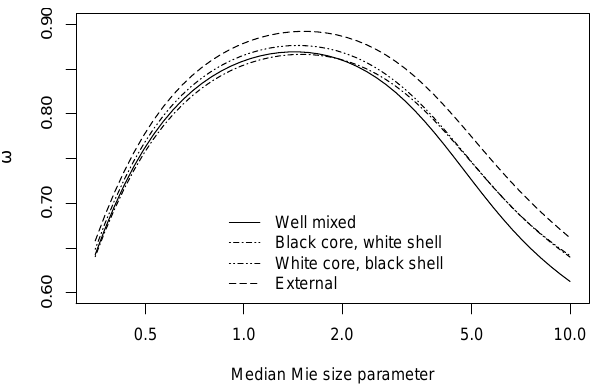
Figure 4. Relative difference of the absorption efficiency for well-mixed and core-shell particles (ω well mixed − ω core shell )/( 1 − ω well mixed ) . The same components as in Fig. 3 are considered where the stronger absorbing component forms the core. In the left panel, the geometric standard deviation σ g = 1 . 59 is used, whereas the mixing ratio is varied. In the right panel, the standard deviation σ g is varied and the mixing ratio is the same as in Fig. 3. The solid red line in the left panel marks the mixing ratio used in the right panel; the solid red line in the right panel marks the standard de- viation used in the left panel. For well-mixed particles, the volume average refractive index mixing rule is